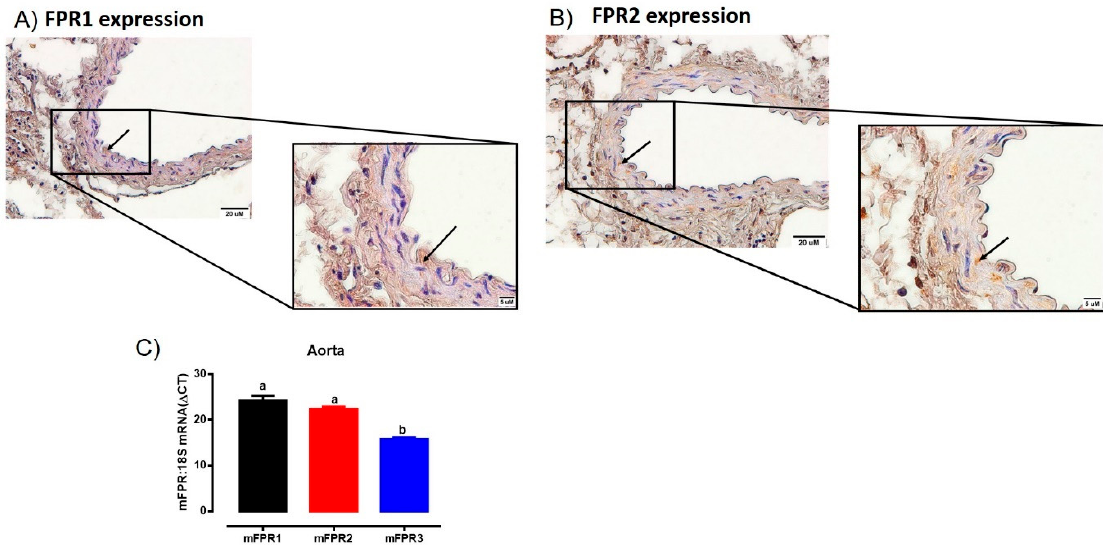
Figure 1. Localisation of FPR1 ( A ) and FPR2 ( B ) protein in the vascular smooth muscle cells in aorta of healthy adult male mice using immunohistochemistry. Arrows indicate positively stained cells. Scale bars = 20 µ m, 5 µ m. ( C ) Quantitative PCR expression of Fpr1 ( Fpr1 ), Fpr2 ( Fpr2 ), and Fpr3 ( Fpr3 ) mRNA in the aorta. Expression is relative to the housekeeping gene ribosomal 18s. Genes that do not share a letter are significantly di ff erent from one another. Values are expressed as mean ± SEM, n =